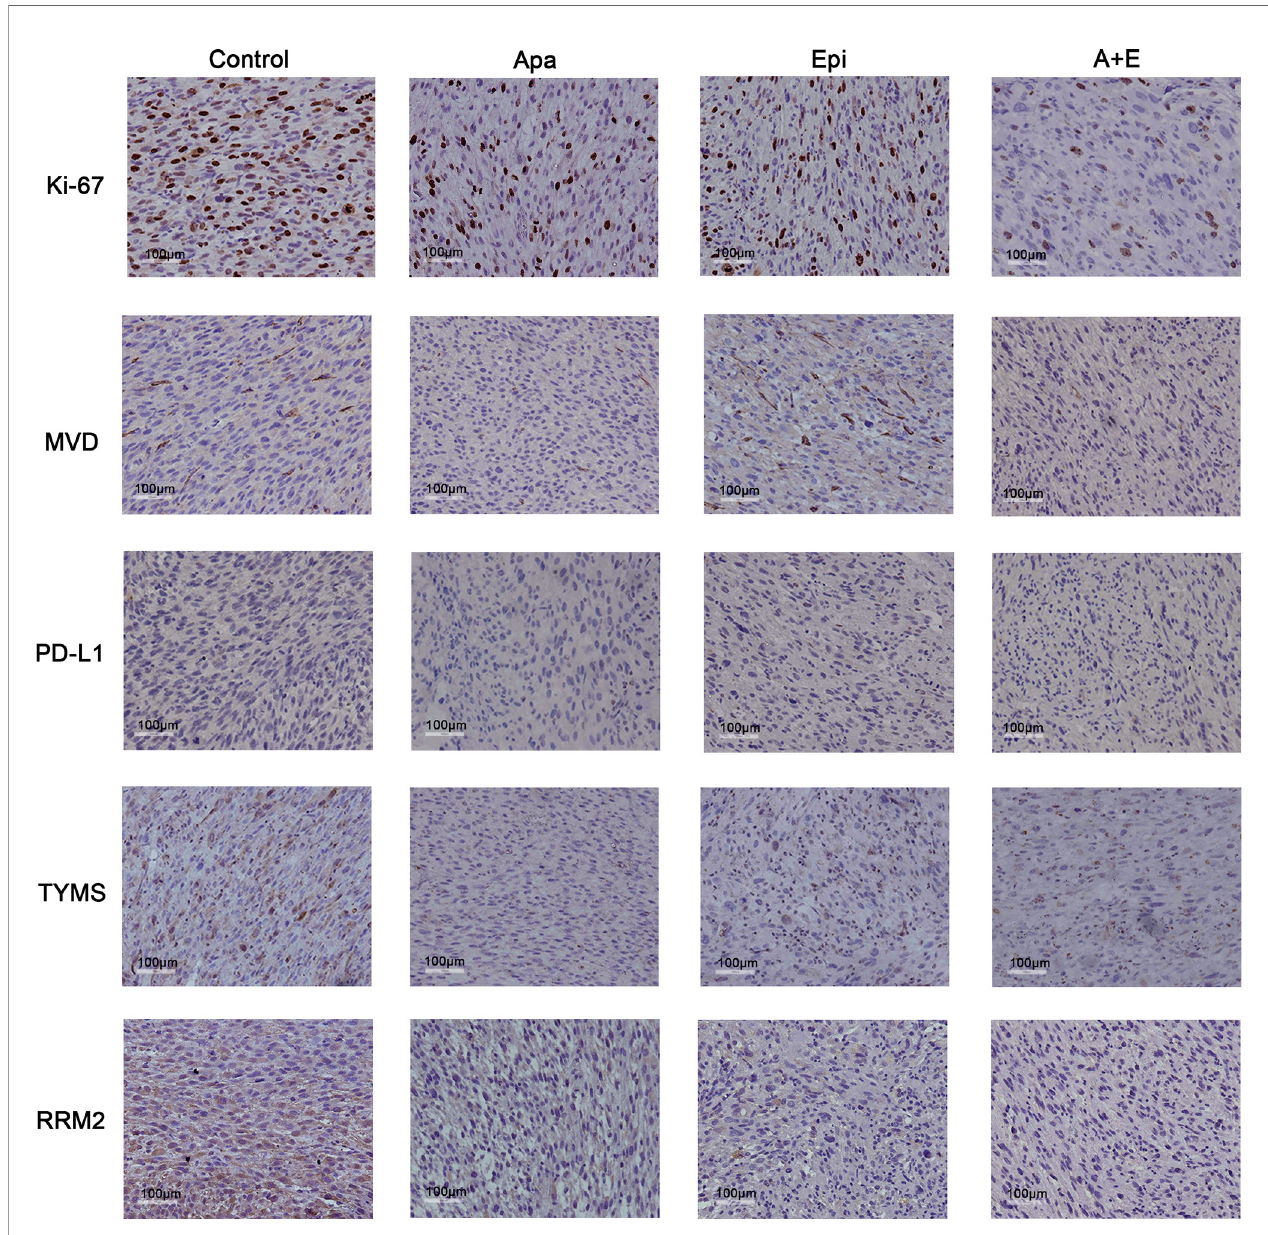
FIGURE 8 | Apatinib decreased MVD and cell proliferation in liposarcoma PDX. IHC analysis of MVD, TYMS, MVD, RRM2, TYMS, Ki-67, and PD-L1 expression in tumor sections from each group. Compared with the control group, Apatinib could down-regulate MVD and the expression of TYMS and RRM2.The positive Ki-67 ratio decreased in all treatment groups. PD-L1 expression did not signi fi cantly differ among groups. ×200 magni fi